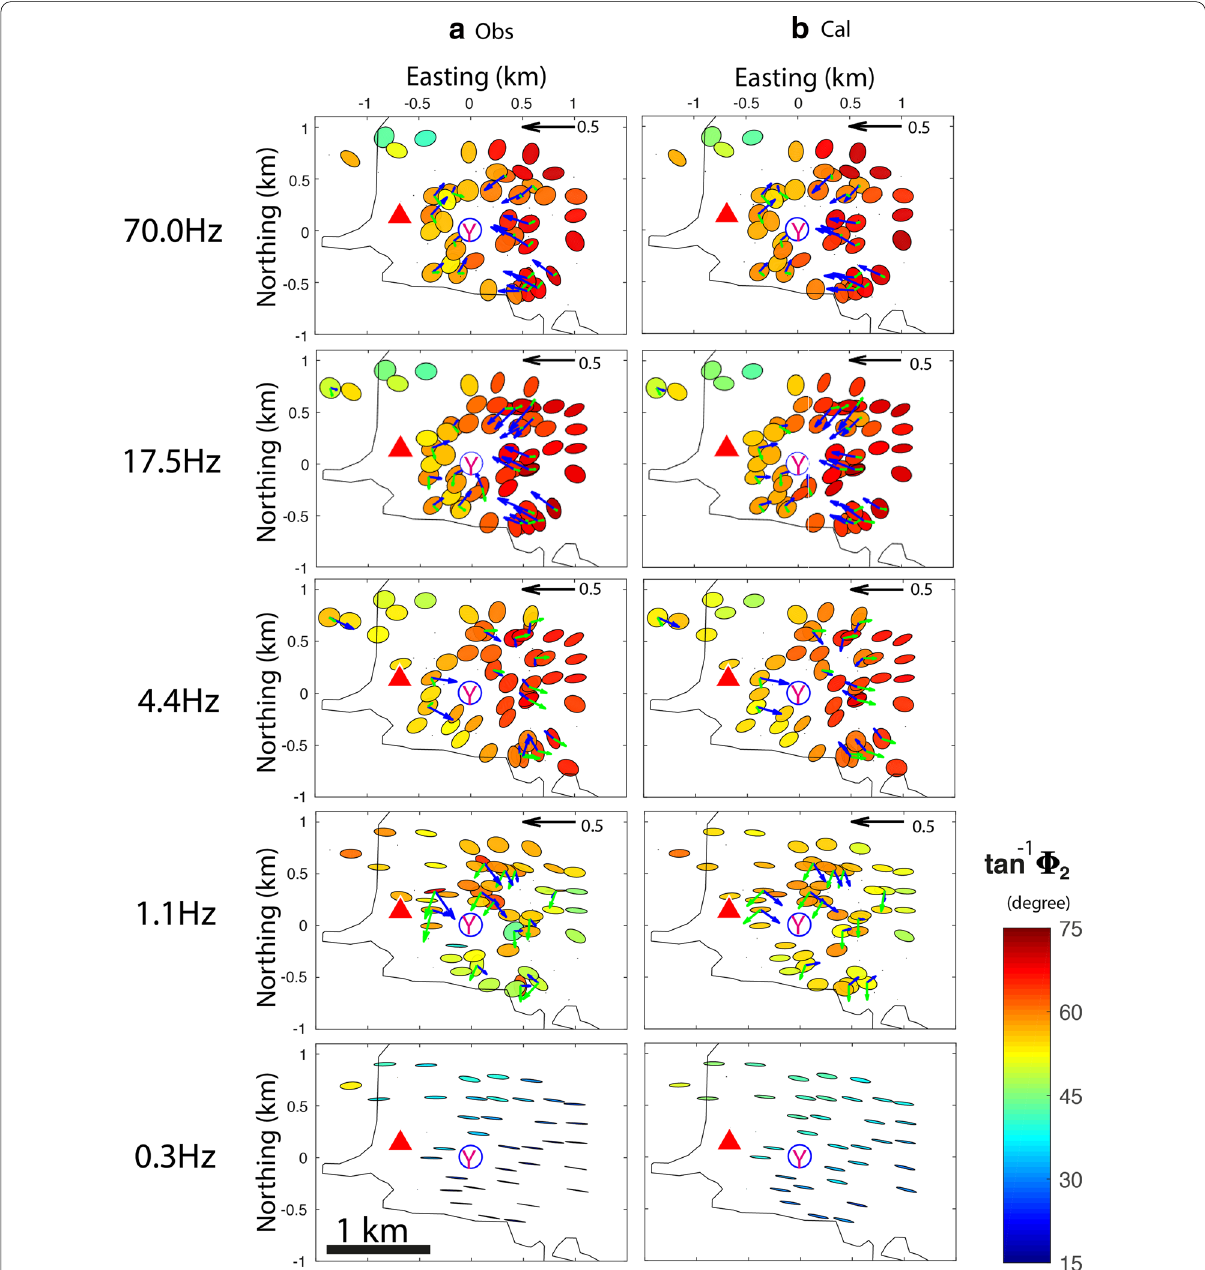
Fig. 2 The phase tensor ellipses map with a the observed and b the calculated data from the final model. The phase tensor ellipses are filled by tan − 1 (cid:31) 2 , where (cid:31) 2 is the geometric mean of maximum and minimum of phase tensor. The blue and green arrows show the real and imaginary parts of the induction vectors with Parkinson convention. The black curve, red triangle, and blue circle with Y denote the national road 292, the peak of Mt. Kusatsu–Shirane and the Yugama crater lake,